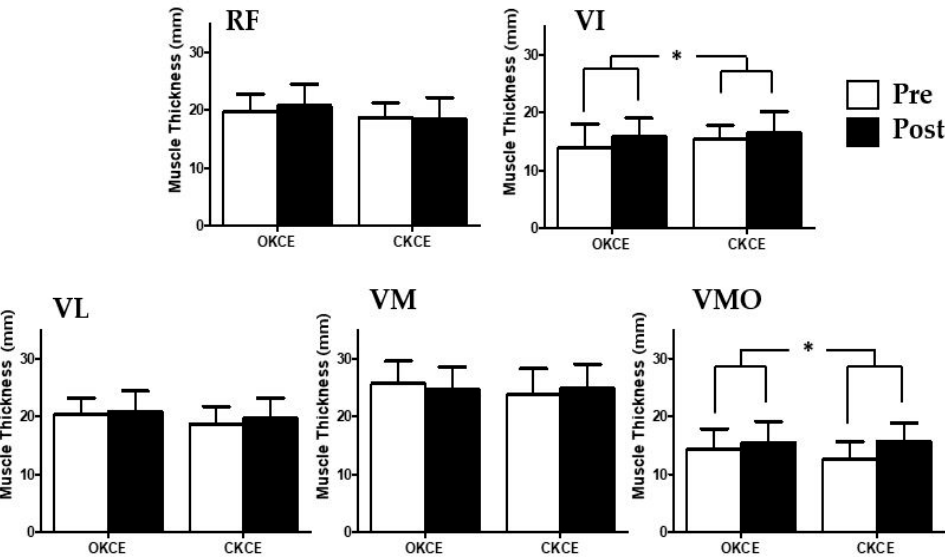
Figure 5. Comparison of the changes in quadricep muscle thickness. OKCE: open kinetic chain exercise, CKCE: closed kinetic chain exercise, RF: rectus femoris; VI: vastus intermedius; VL: vastus lateralis; VM: vastus medialis; VMO: vastus medialis oblique. * p < 0.05 indicates a significant difference between pre- and post-intervention within the group.